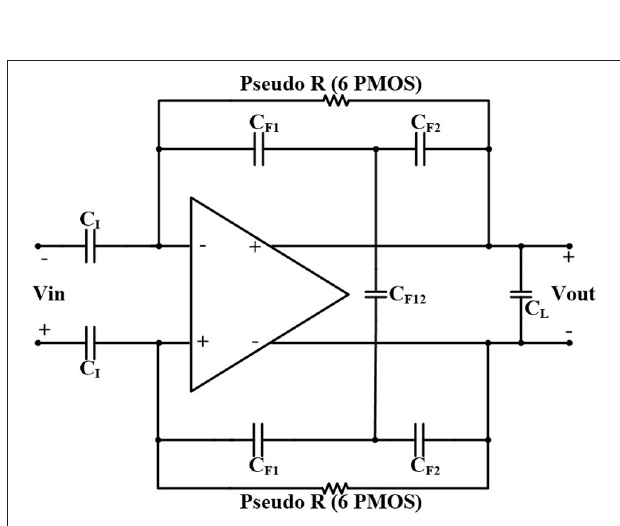
FIGURE 7 | Small signal equivalent circuit of the neural amplifier with a CCPF connection.